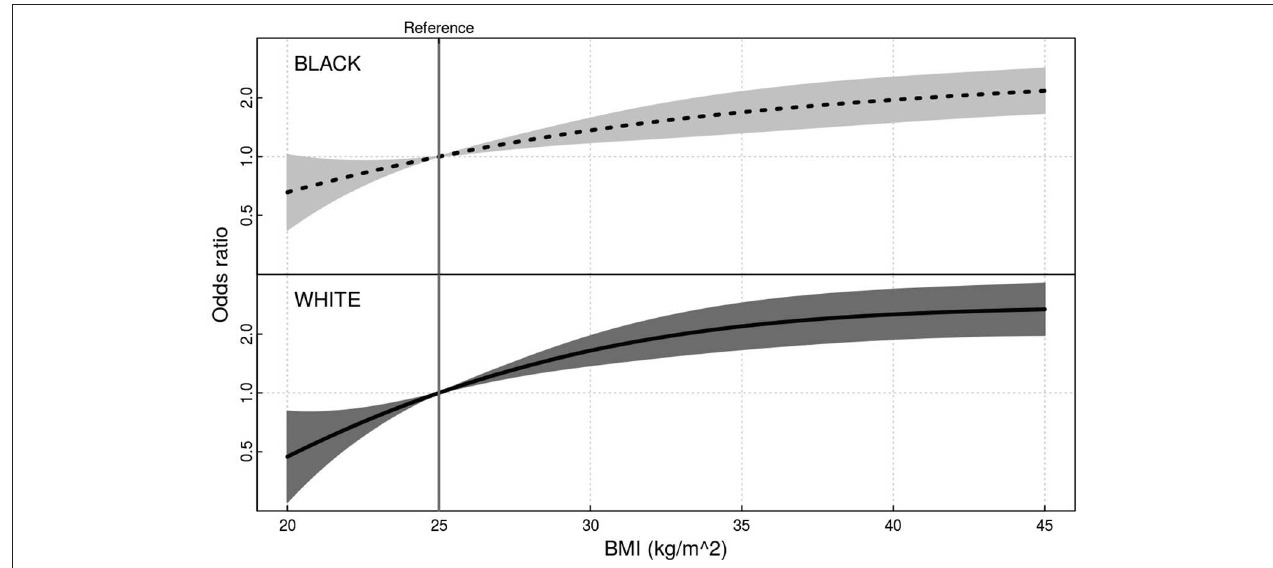
FIGURE 2 | Odds ratio of NAFLD over BMI by